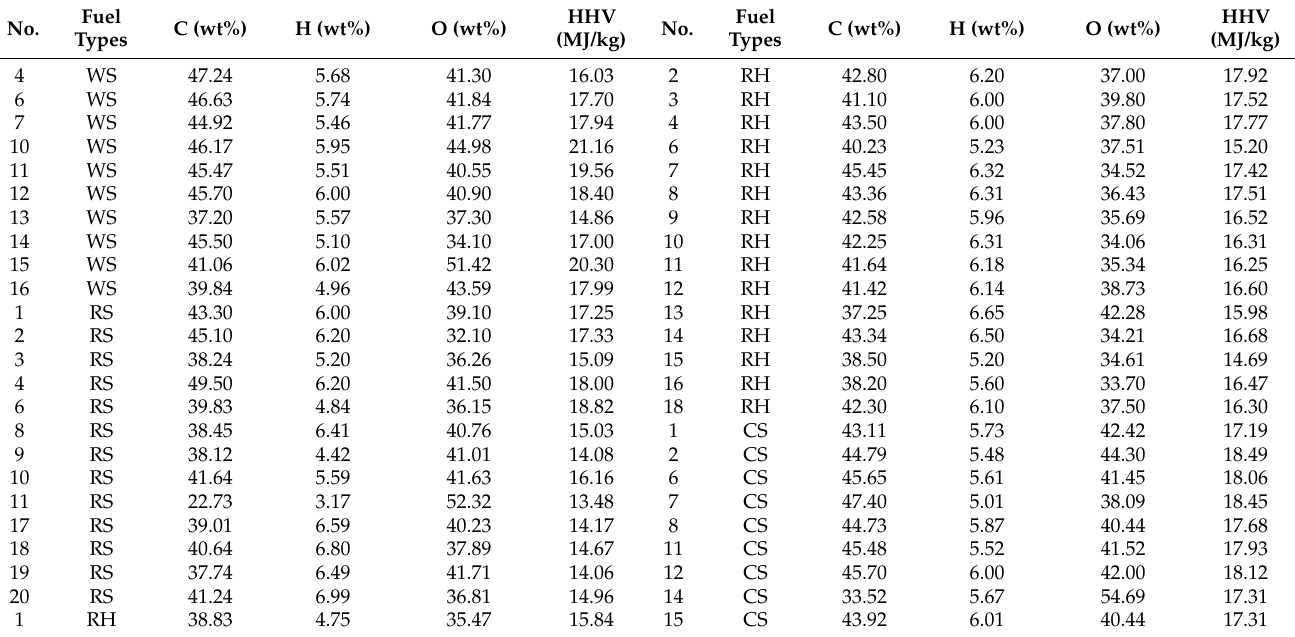
Table 2. Summary of C (wt%), H (wt%), and O (wt%) along with HHV results (MJ/kg) in dry-basis.